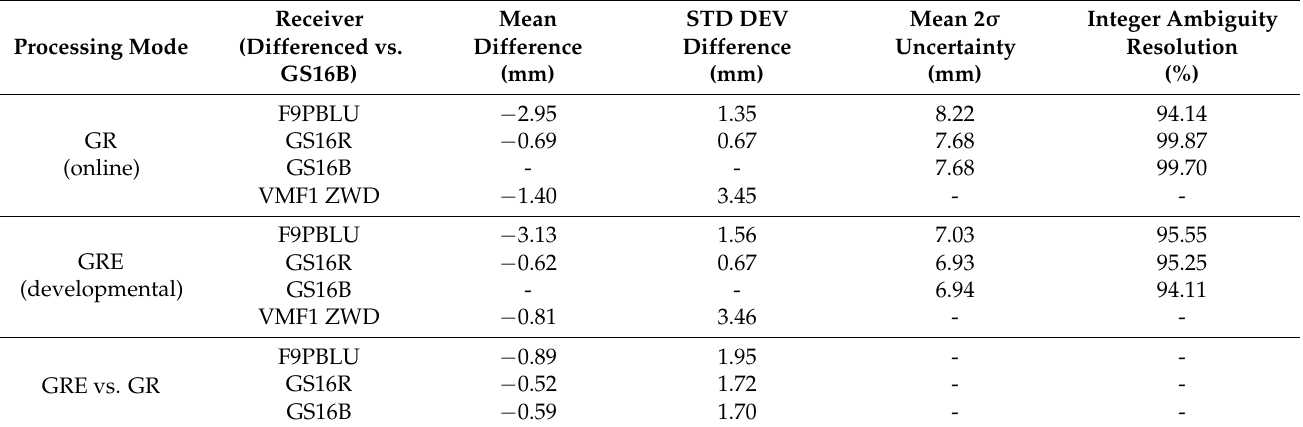
Table 1. Static Dataset A ZWD profile mean differences, standard deviations and average 2 σ values for GR, GRE, and VMF1, and integer ambiguity resolution success rates.